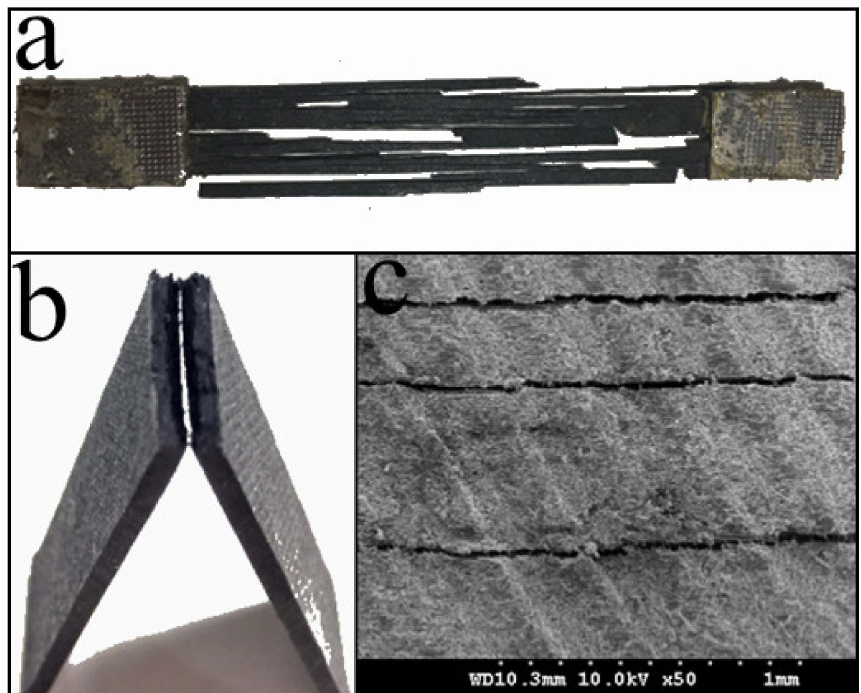
Figure 14. Fracture modes of the 3D-printed CCF / E-20 after ( a ) the tensile test, ( b ) the three-point bending test, and ( c ) the interlaminar shear